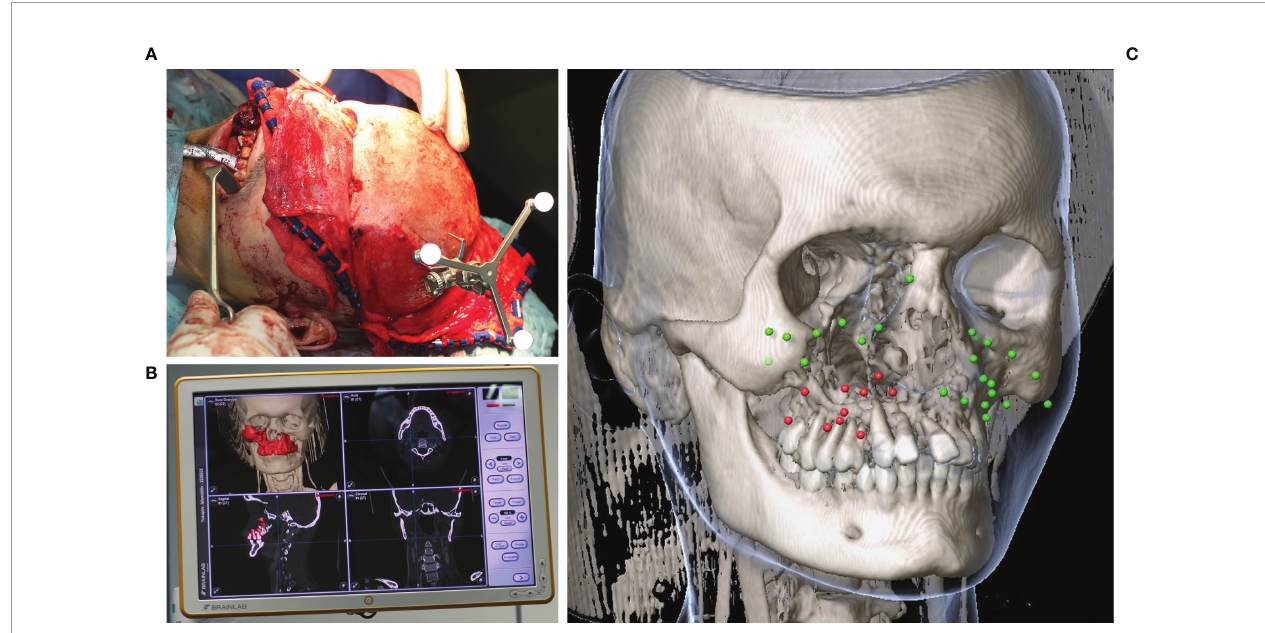
FIGURE 5 | Intraoperative navigation during midfacial tumor ablation in a case of Ewing ’ s sarcoma of the midface. (A) Skull reference array attached for intraoperative navigation after coronal approach. (B) Real time navigation monitor showing the planned bony resection segmented in red color. (C) Data post- processing of the landmarks set intraoperatively after receipt of the histopathological report (green = tumor-free, red = tumor